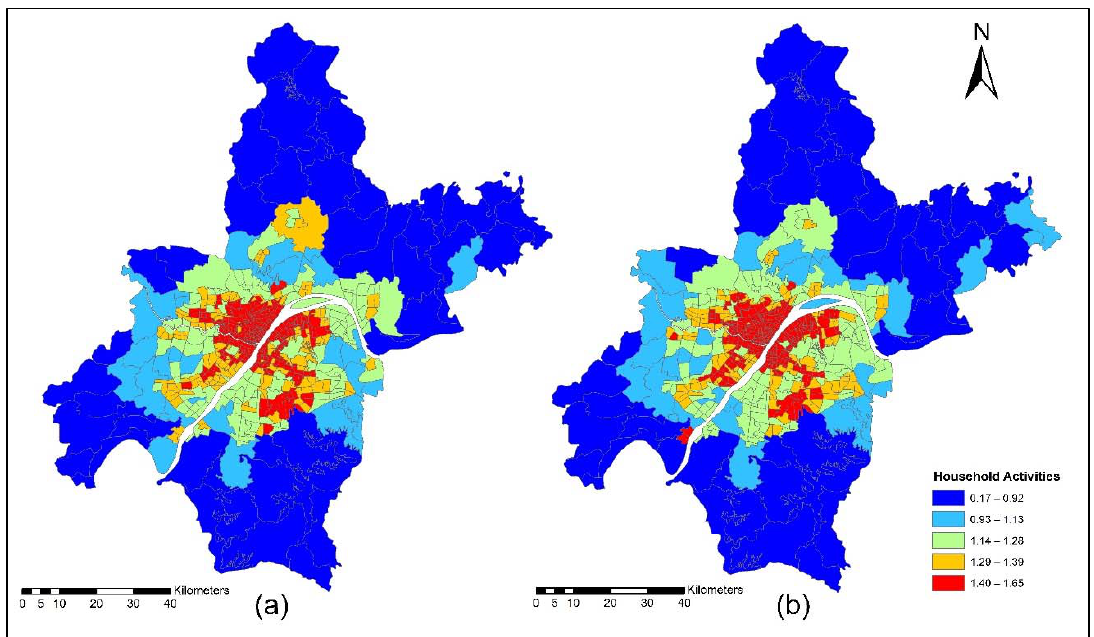
Figure 12. ( a , b ) Accessibility of household activities: ( a ) during evening peak for the year 2012; ( b ) during evening peak for the year 2015.